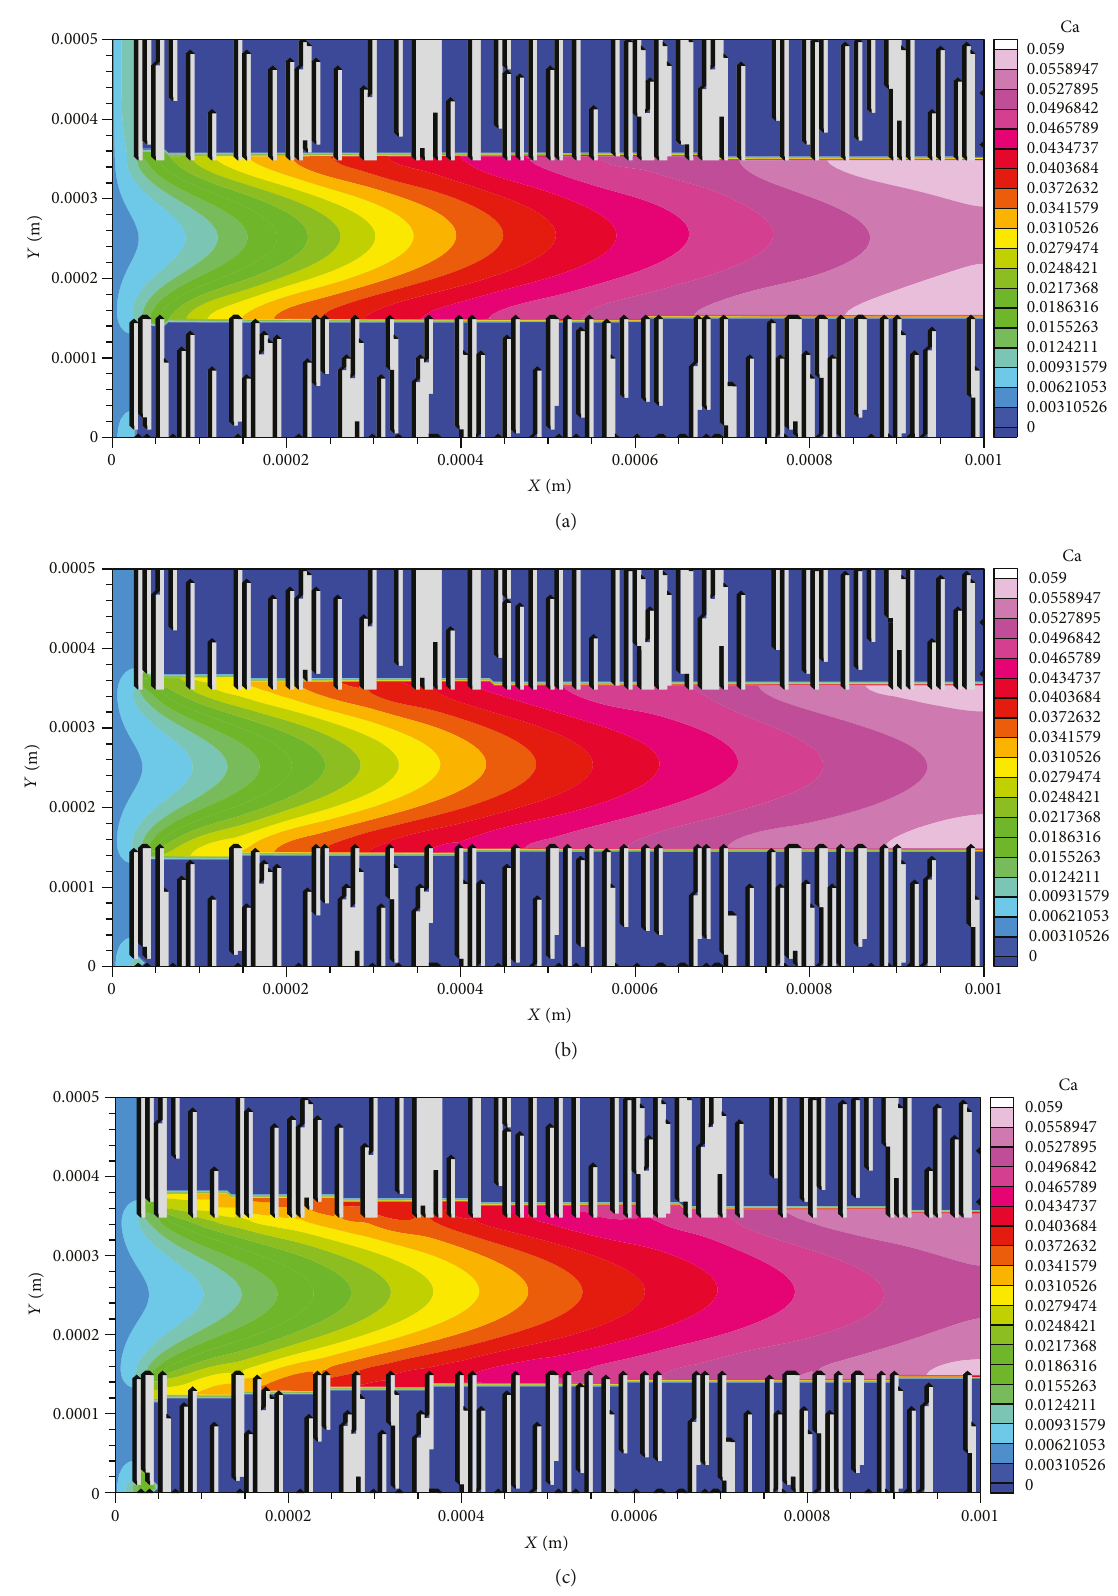
Figure 21: Ca concentrations (mol/L) at (a) t = 1 3 hr, (b) t = 2 8 hr, and (c) t = 6 4 hr. In all three cases, Pe =2.6 and kaolinite is illustrated in light